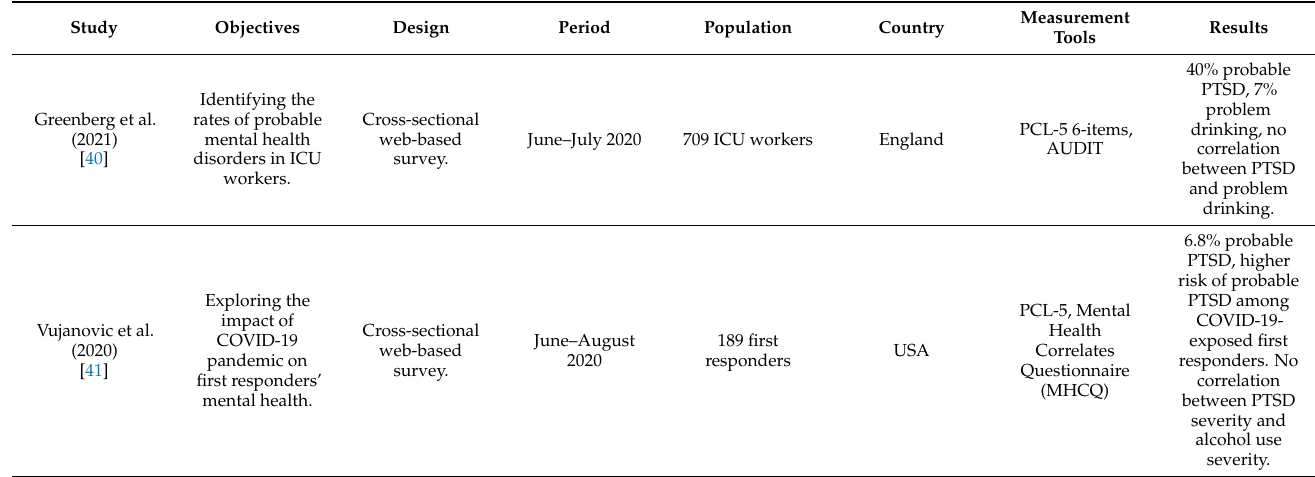
Table 5. Summary of the main data of the studies considered in this review—Healthcare